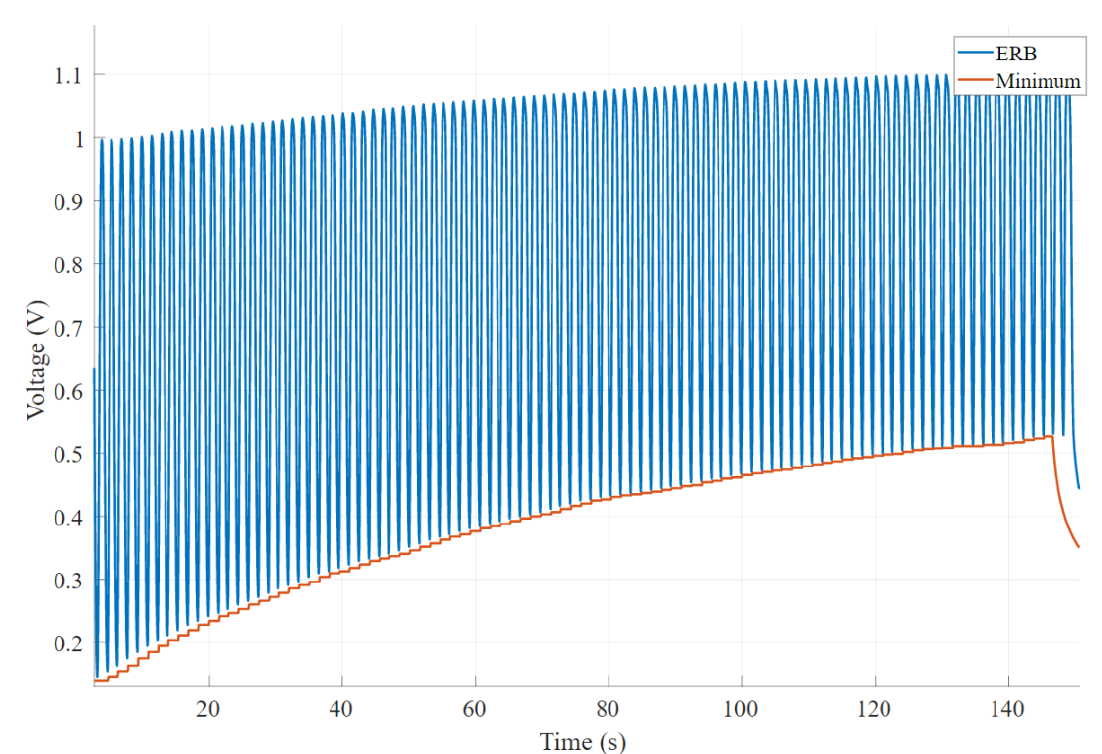
Figure 6. An example of undesired voltage output where baseline changes significantly with